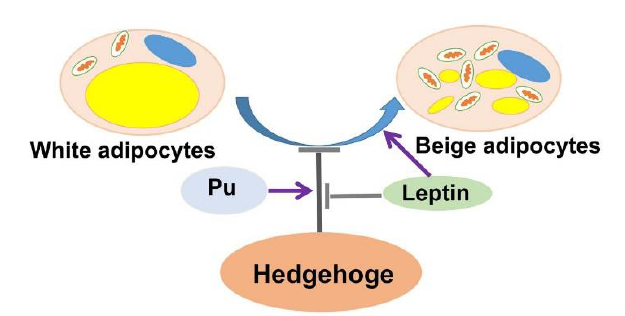
Figure 7. Graphical display of the interplay between leptin and the Hh signaling pathway in adipocyte browning.